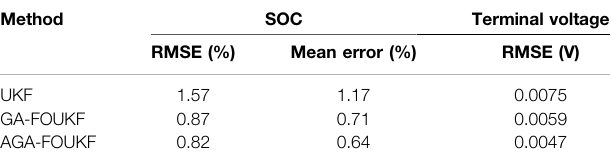
TABLE 4 | Statistics of estimated SOC and terminal voltage under pulse